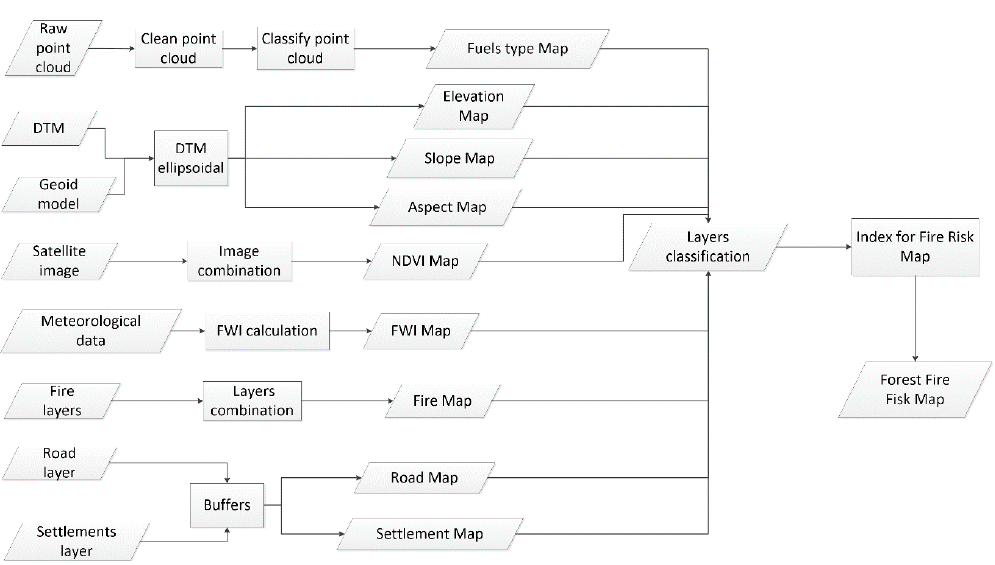
Figure 2. Workflow of the methodology to determine forest fire risk map.